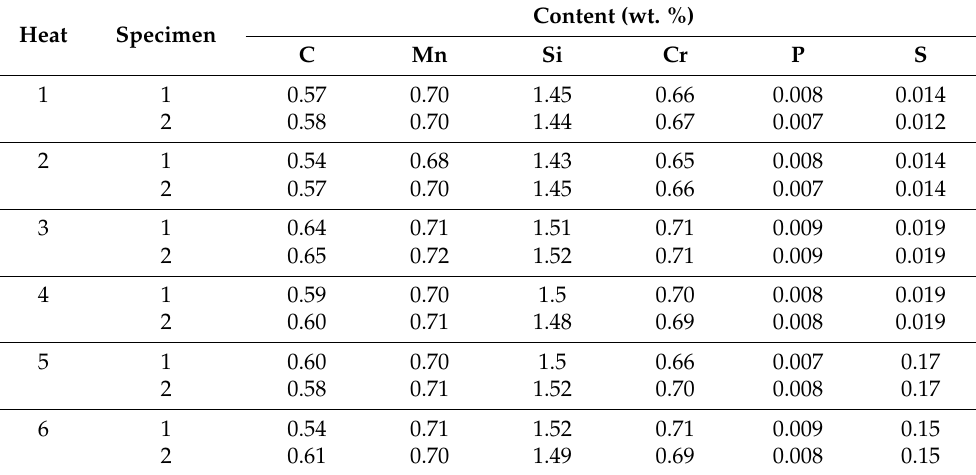
Table 1. Chemical composition (wt. %) of the studied heats.